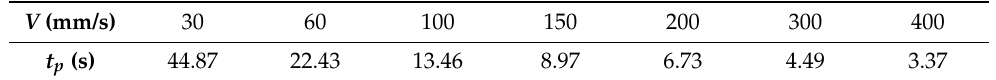
Table 2. Pressure holding time of 3 N/mm laying pressure probe